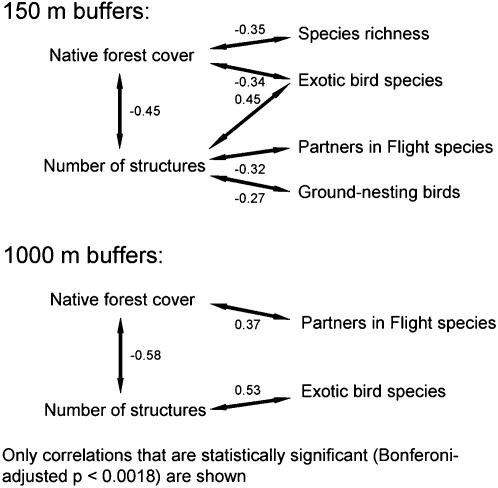
Summary of Pearson correlations between landscape metrics and bird community characteristics.Only statistically significant correlations are shown (see Table 3 for listing of all correlations, regardless of significance).All buffers were calculated around the locations of point counts in exurban areas.